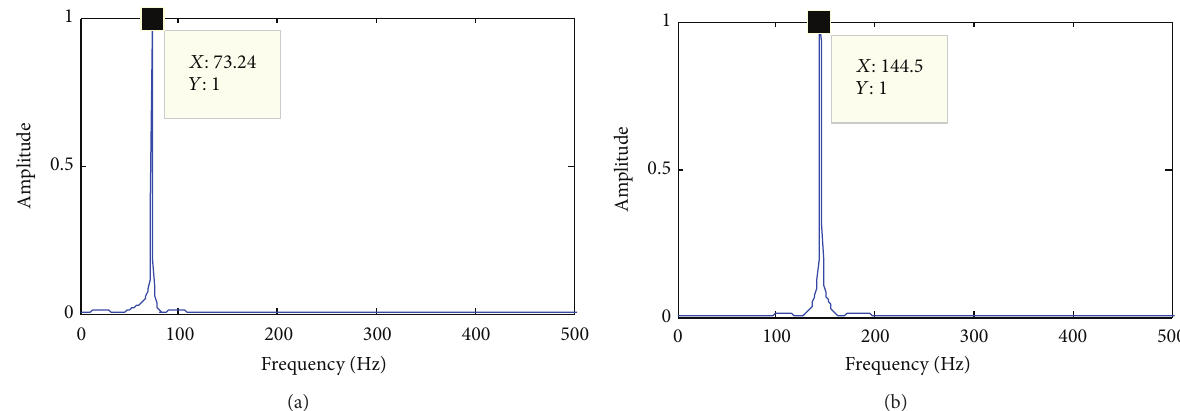
Figure 10: (a) Fault characteristic frequency and (b) twice the fault characteristic frequency.